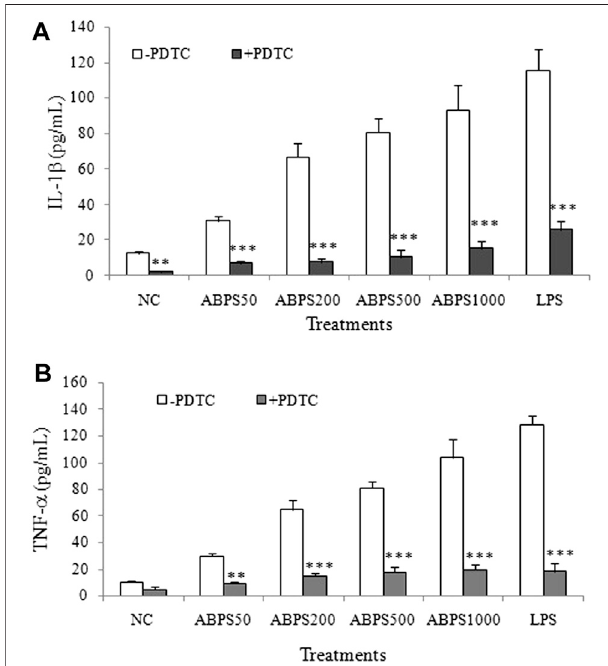
FIGURE 6 | Effect of NF- κ B inhibitor (PDTC) on ABPS induced the secretion of IL-1 β and TNF- α . The cells were pretreated with or without 100 μ g/ml anti-TLR2antibody for2 h andthen treated withABPS(0, 50, 200, 500, and 1,000 μ g/ml, respectively) or LPS (5 μ g/ml) for 24 h. Cell culture medium was collected, and the secretion levels of cytokines (A) IL-1 β and (B) TNF- α were detected. NC: normal control; ABPS50: 50 μ g/ml ABPS treated; ABPS200: 200 μ g/ml ABPS treated; ABPS500: 500 μ g/ml ABPS treated; ABPS1000: 1,000 μ g/ml ABPS treated; and LPS: 5 μ g/ml LPS treated (positive control). ** p < 0.01, *** p < 0.001 vs. control (without antibody treatment group). The values are presented as means ±